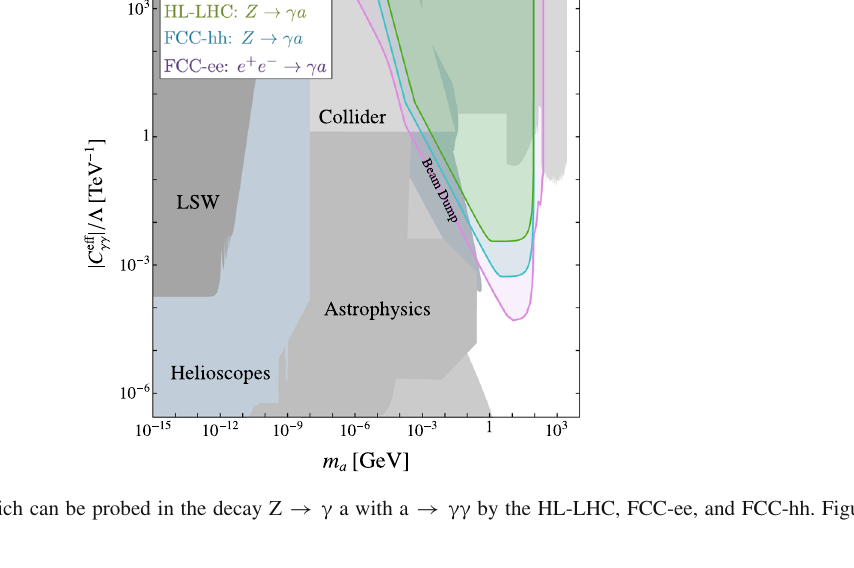
Fig. 12.5 that FCC-ee and FCC-hh open unexplored territory in the intensity frontier, probing the dark sector at interaction strengths that are typically considered the realm of the intensity frontier, as can be seen from the comparison with beam